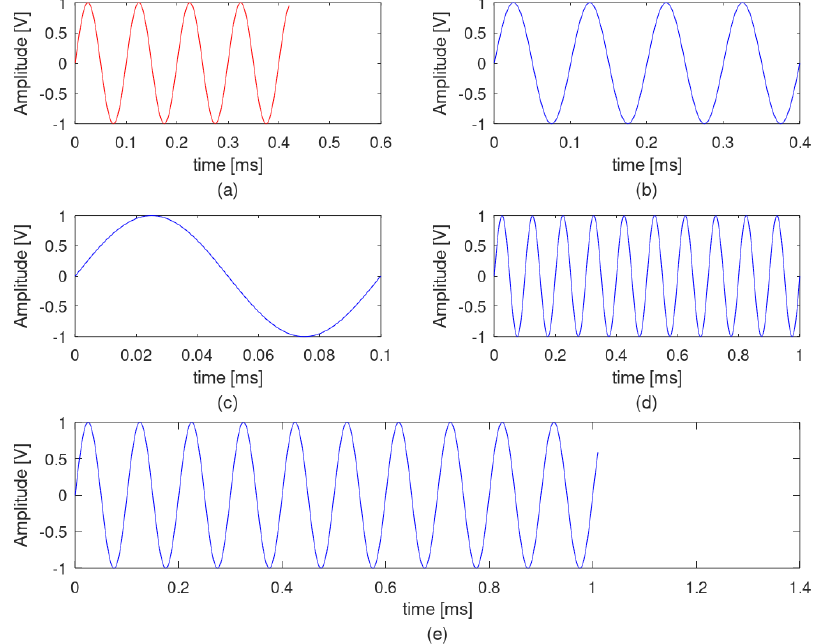
Figure 6. Example of different observation windows of the same sinusoidal signal at 10 kHz in the time domain. Observation time interval includes ( a ) four full periods of 10 kHz signal, but it is not an integer multiple of the 10 kHz signal period (0.42 ms); ( b ) exactly four full periods of 10 kHz signal (0.4 ms); ( c ) exactly one full period of 10 kHz signal (0.1 ms); ( d ) exactly ten full periods of 10 kHz signal (1 ms); and ( e ) ten full periods of 10 kHz signal, but it is not an integer multiple of the 10 kHz signal period (1.01 ms).